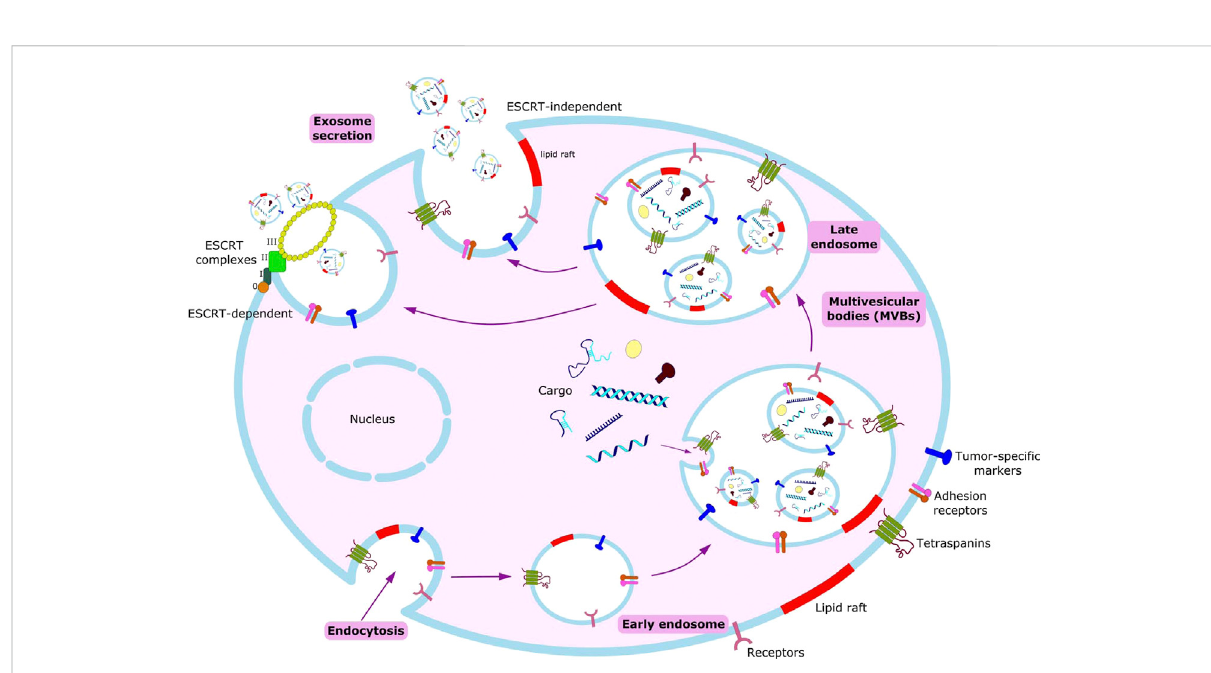
FIGURE 2 Scheme of exosome biogenesis and